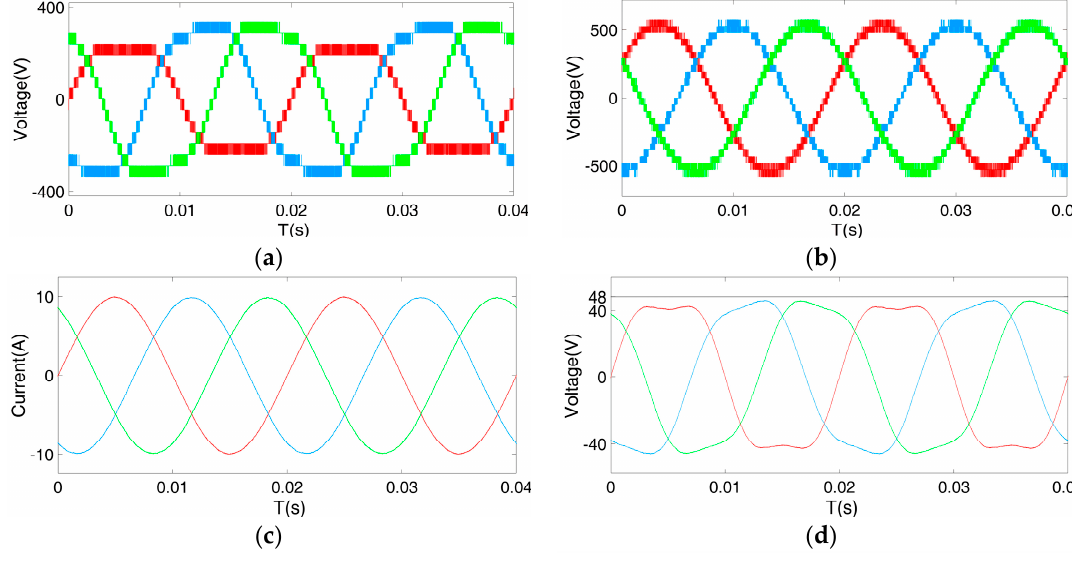
( f ) ( f ) Figure 9. Waveforms for the “577” operation state: the ( a ) three-phase converter output voltage; ( b ) three-phase line-to-line voltages; ( c ) grid current; ( d ) three-phase sub-module modulating waveform;